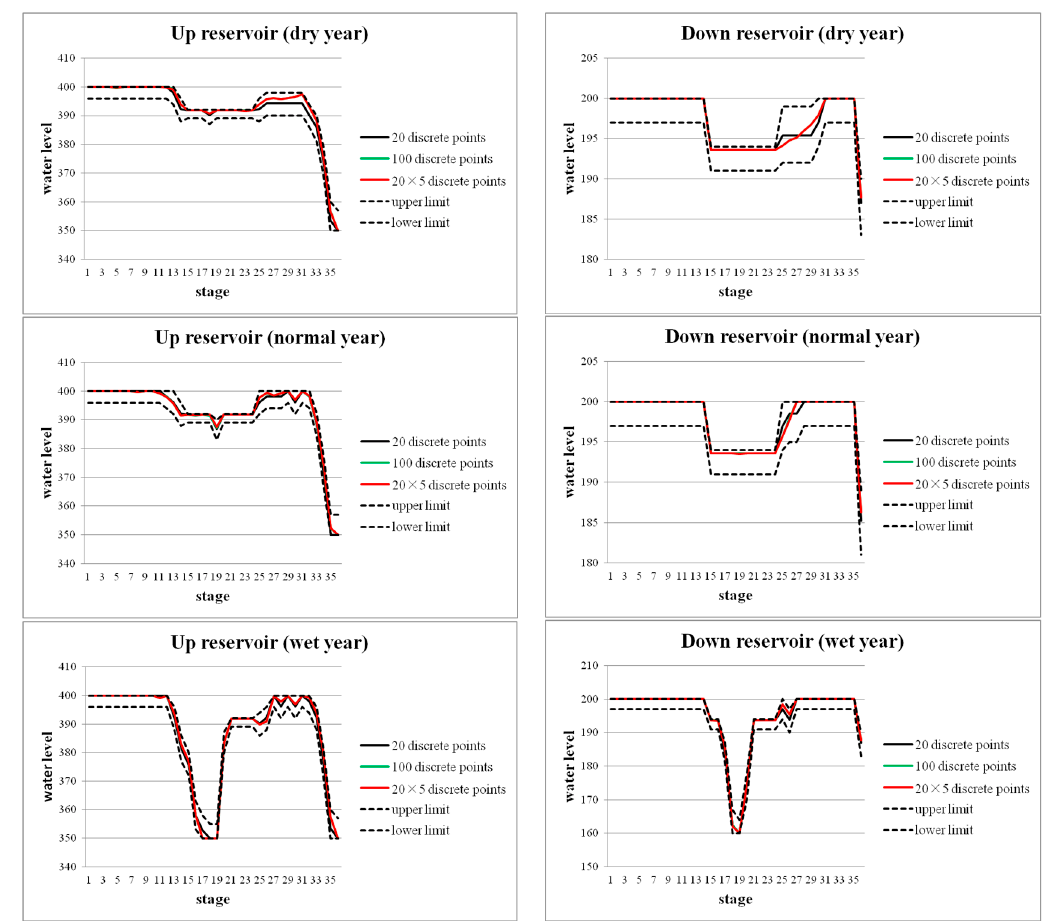
Figure 7. Storage water level variations of scheme “IMDP: 20 × (20/4)”.